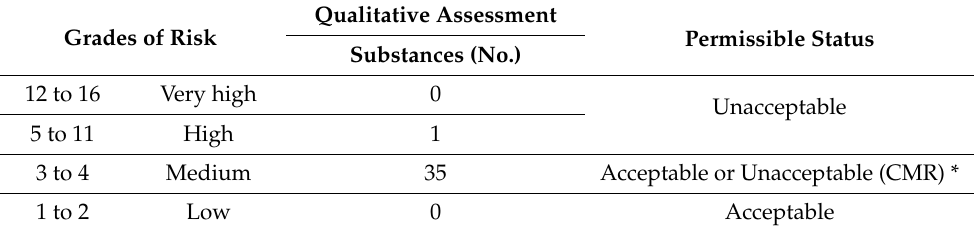
Table 5. Qualitative risk assessment results for hazardous substances requiring